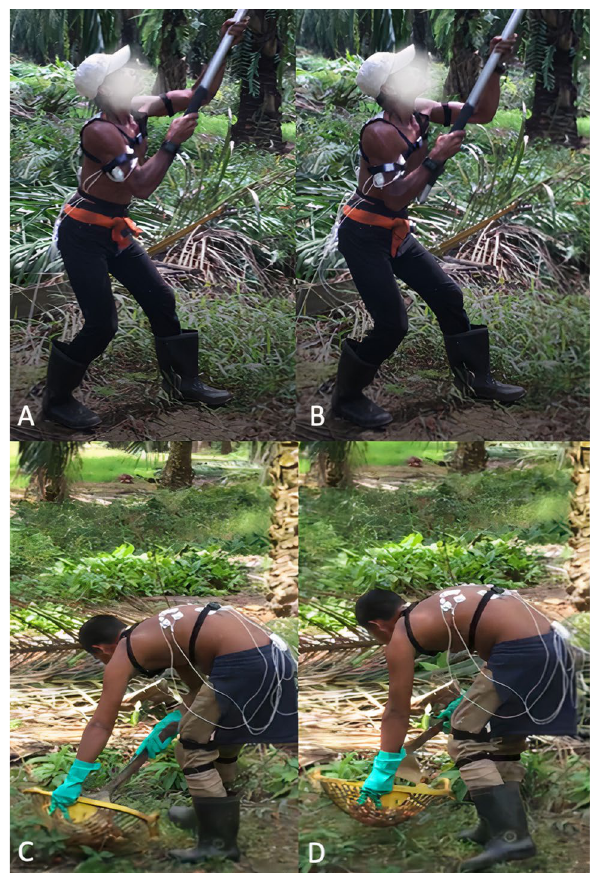
Figure 1. ( A , B ): An example of an oil palm FFB harvesting posture ( C , D ): An example of an oil palm LF collection